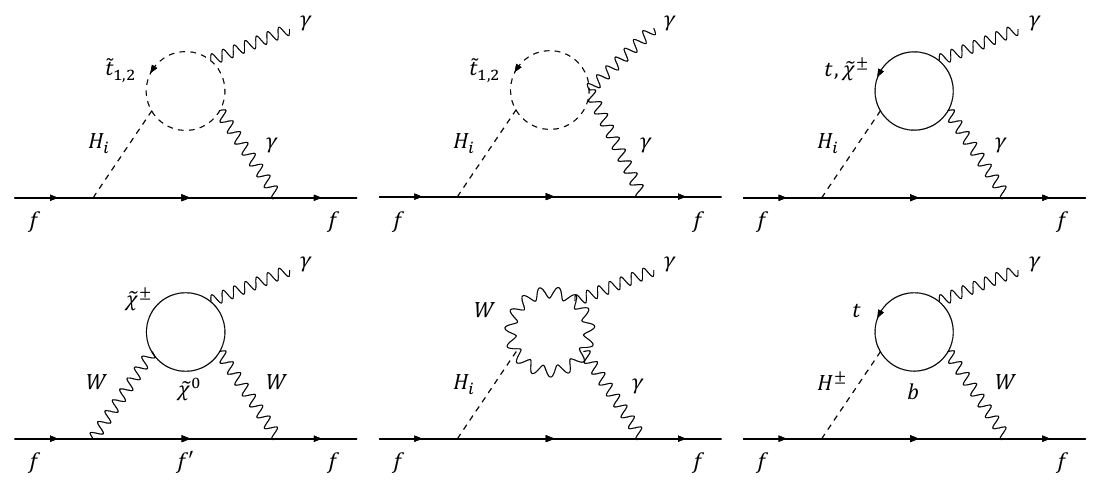
Figure 6 . The two-loop diagrams dominantly contributing to the EDM of a fermion f (there are also mirror graphs). The two top left diagrams include stop loops. The top right diagram denotes contributions of top quark and chargino loops. The bottom left diagram shows the W EDM contribution. The bottom middle diagram includes W boson loops. The bottom right diagram shows the contribution of top/bottom quark loops through charged Higgs bosons.